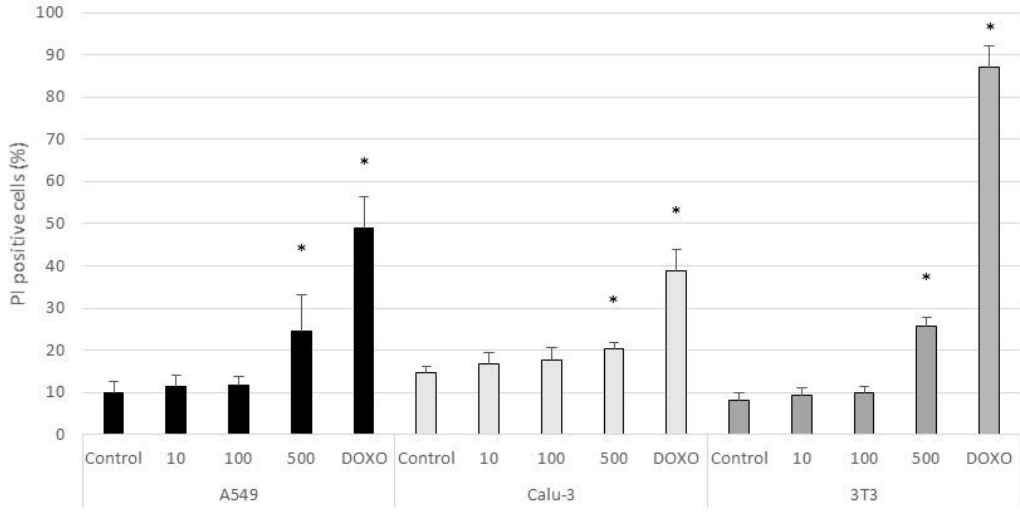
Figure 7. Necrosis in control A549, Calu-3, and 3T3 cells and in cells exposed for 24 h to CeO 2 -NPs (10, 100, and 500 µg/mL), and to the positive control Doxorubicin. Results are expressed as means ± SD of six replicates per tested condition and three independent assays ( n = 18). Asterisks indicate significant differences with respect to the untreated control cells ( p < 0.05).